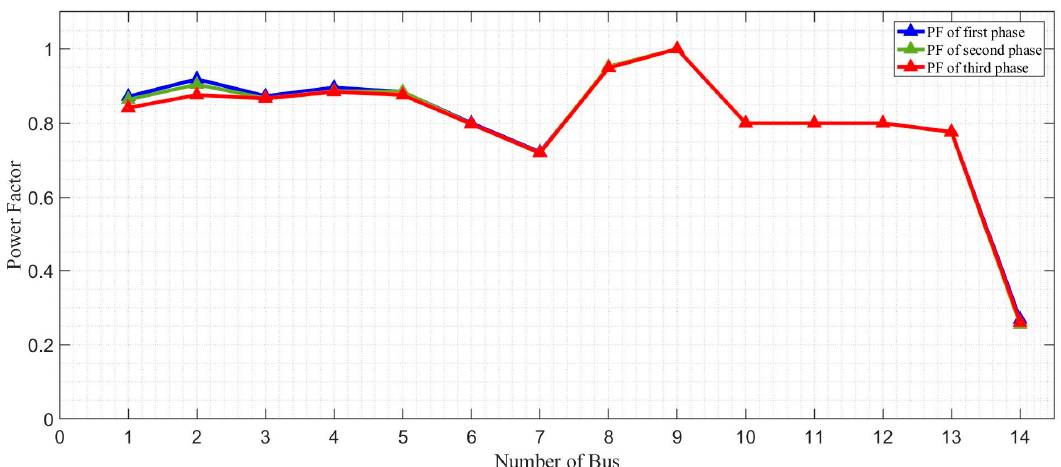
Figure 19. Minimum demand power-factor.